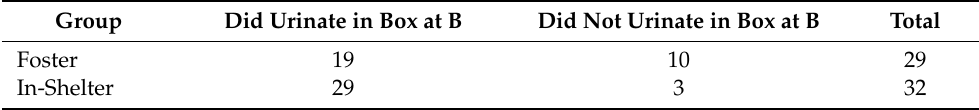
Table 2. Number of cats urinating in the litter box at time point B by group.